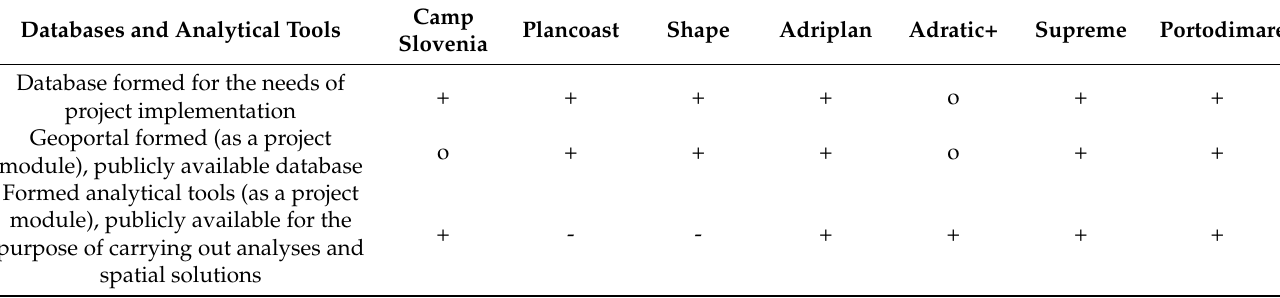
Table 13. Formed and used databases and analytical